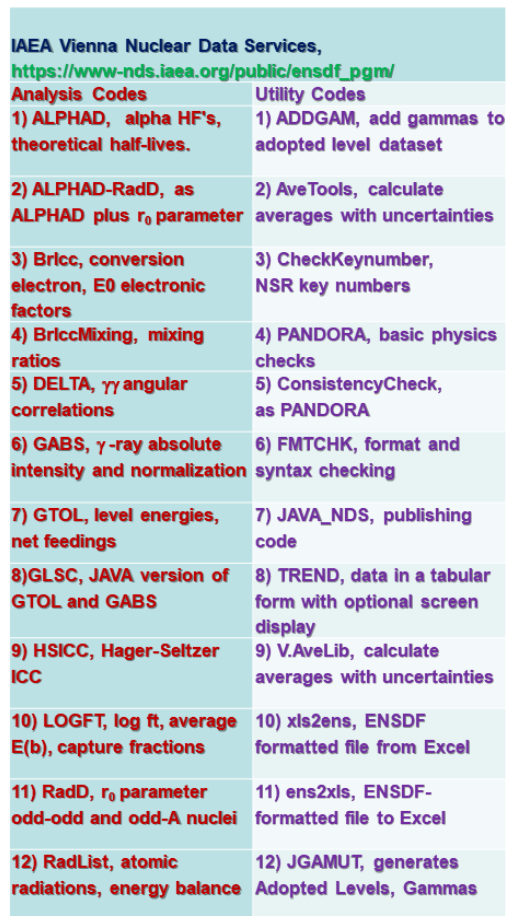
Figure 3. ENSDF Analysis and Utility Codes.